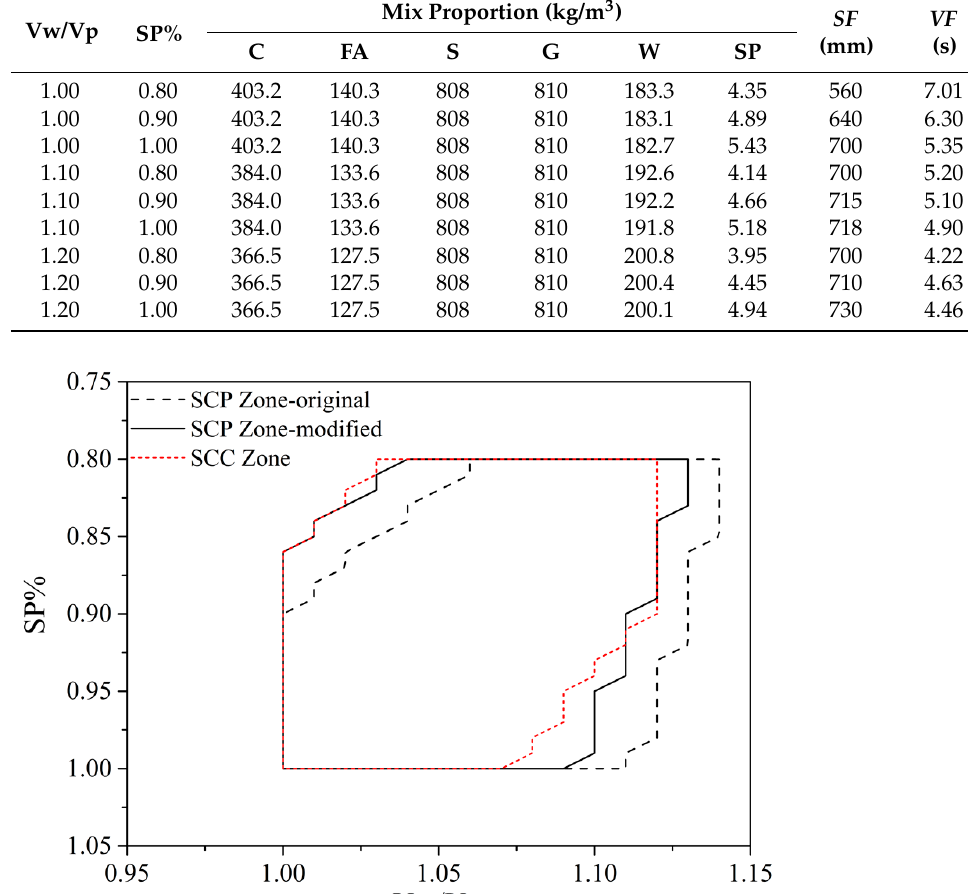
Table 9. Mix proportions and test results of SCC in series 3.